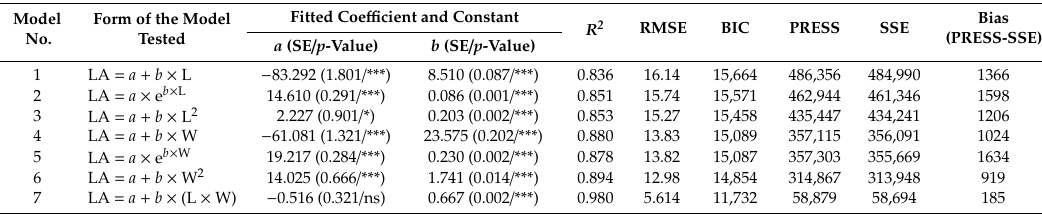
Table 4. Fitted constant ( a ) and coe ffi cient ( b ) of the models used to estimate the loquat leaf area (LA in cm 2 ) of single leaves from leaf length (L) and leaf width (W) measurements. The standard errors and p -value in parenthesis; L and W were in cm. All data were derived from the calibration Experiment 2015 ( n = 1890 leaves).